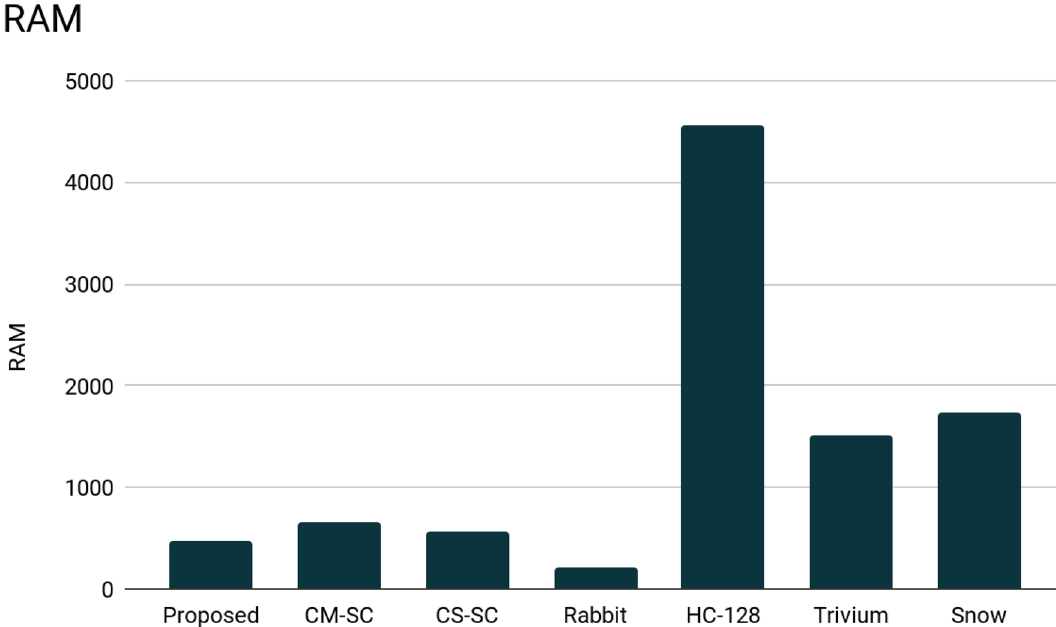
Figure 6. The comparison of the RAM consumption of the proposed system with different encryption algorithms.